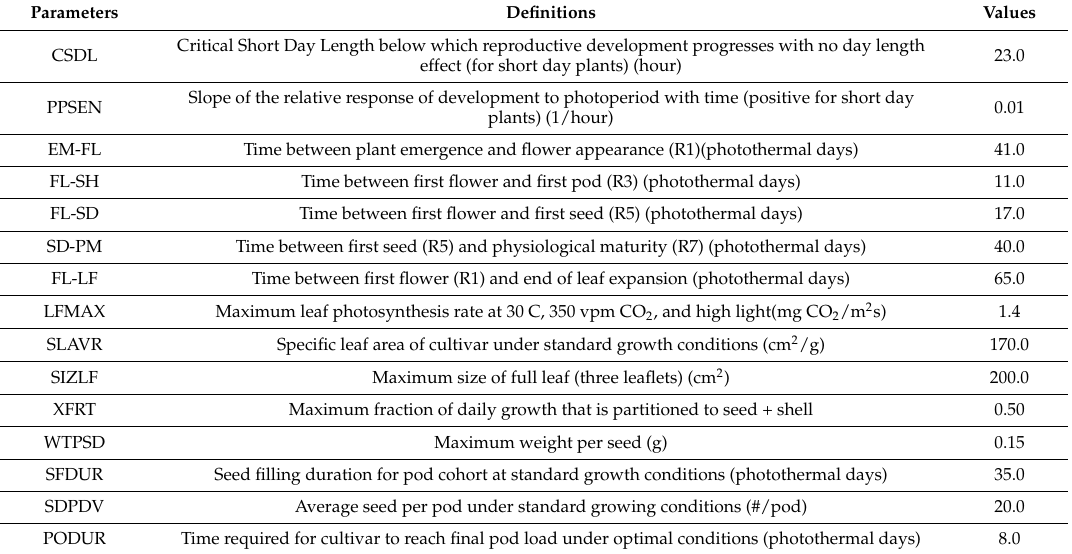
Calibrated cultivar parameters for simulating cotton c.v. ST5599BR using the CSM-CROPGRO-cotton model